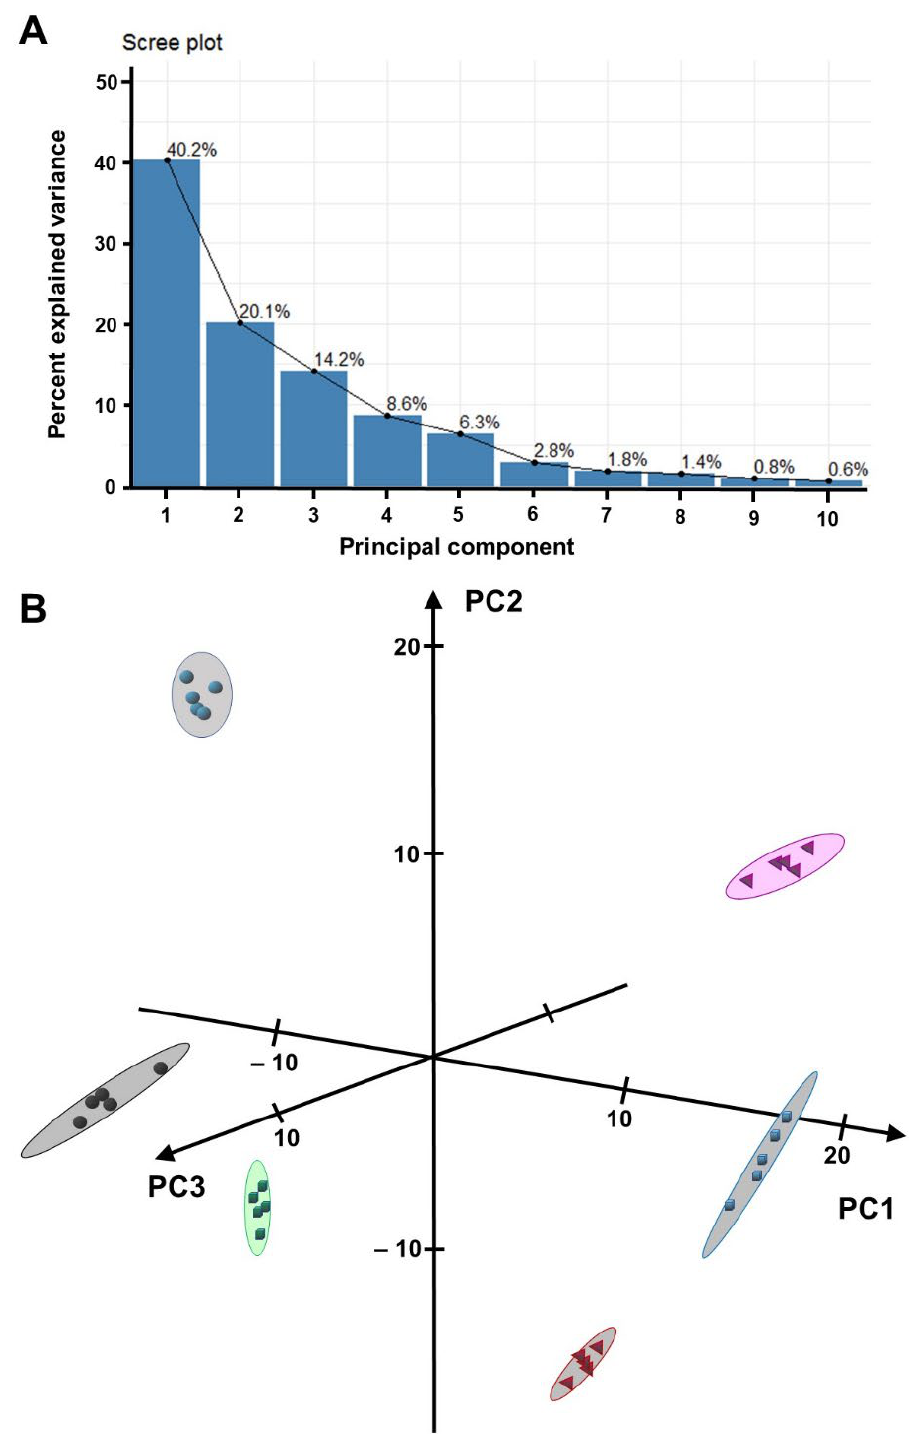
Figure 2. Separation of Equisetum sample groups based on a principal component analysis (PCA) of metabolomics data. ( A ) Scree plot indicating that the first three principal components (PCs) explain 74% of variance across datasets. ( B ) Three-dimensional PCA plot visualizing the separation of samples from Equisetum arvense shoots (red pyramids), Equisetum arvense rhizomes (black spheres), Equisetum hyemale shoots blue cubes), Equisetum hyemale rhizomes (green cubes), Equisetum telmateia shoots (magenta pyramids), and Equisetum telmateia rhizomes (teal spheres).